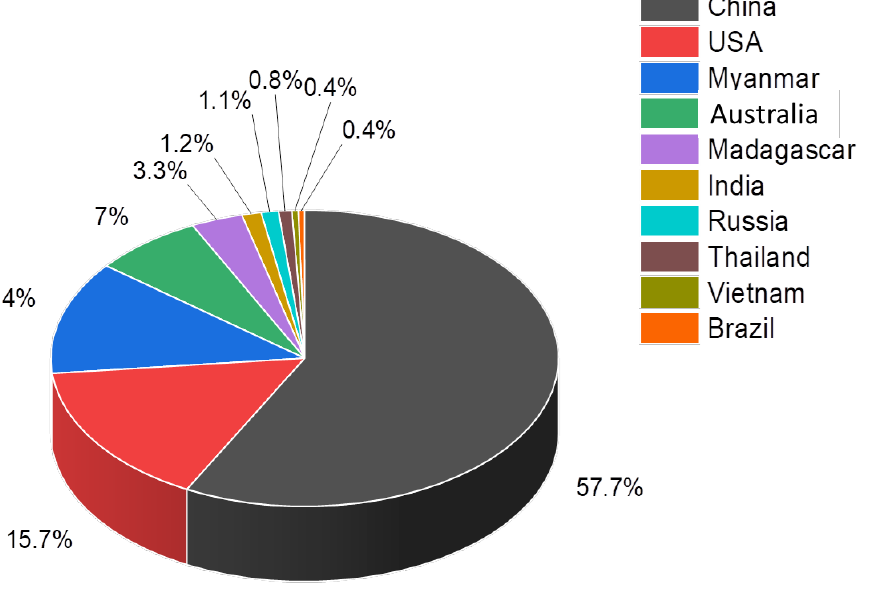
Figure 3. Leading global producers of REEs in 2020